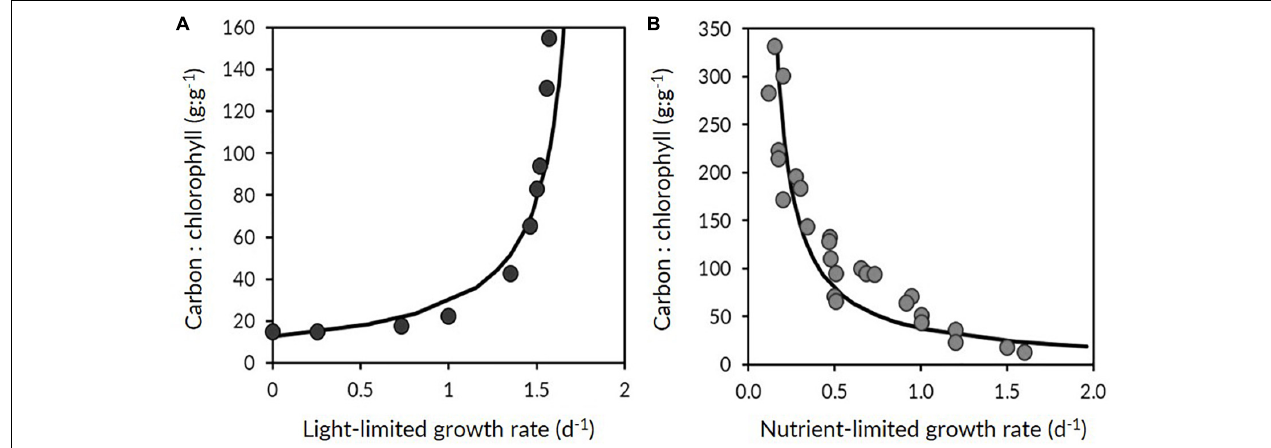
FIGURE 2 | Contrasting relationships between phytoplankton carbon-to-chlorophyll ratios ( θ ) and growth rate ( µ ). (A) Relationship between θ and µ as typically observed in nutrient-replete and light-limited phytoplankton. (B) Relationship between θ and µ under steady-state light-sufficient and nutrient-limiting conditions. Adapted from Behrenfeld et al. (2016), data are from Laws and Bannister (1980) and Halsey et al. (2014).